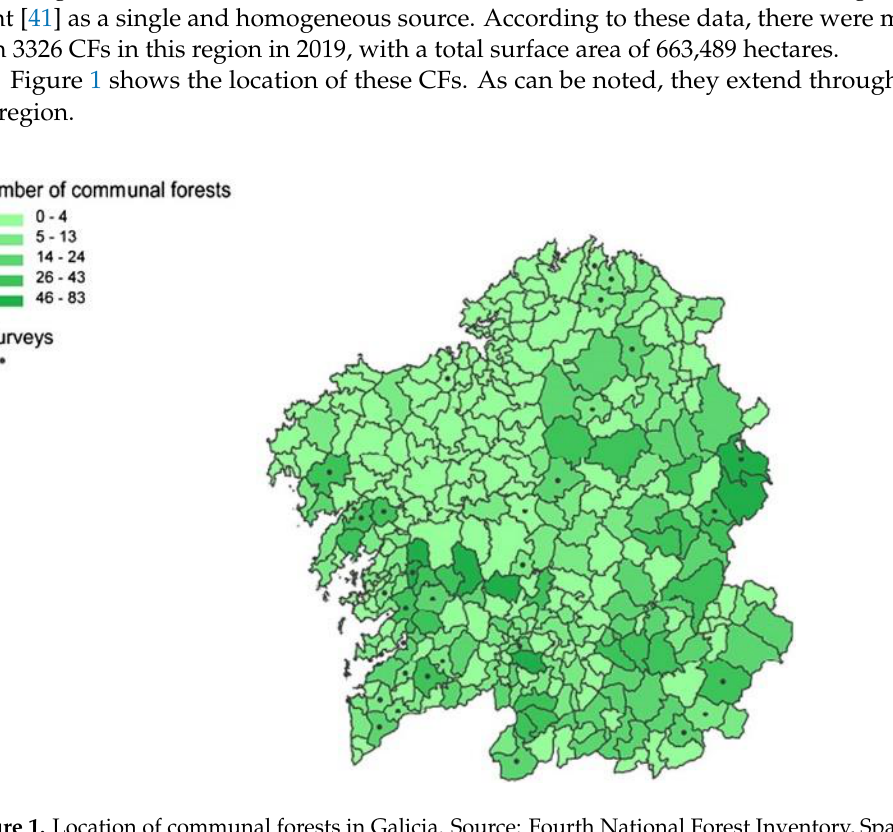
Table 1. Number and area of Communal Forest by district (2019).